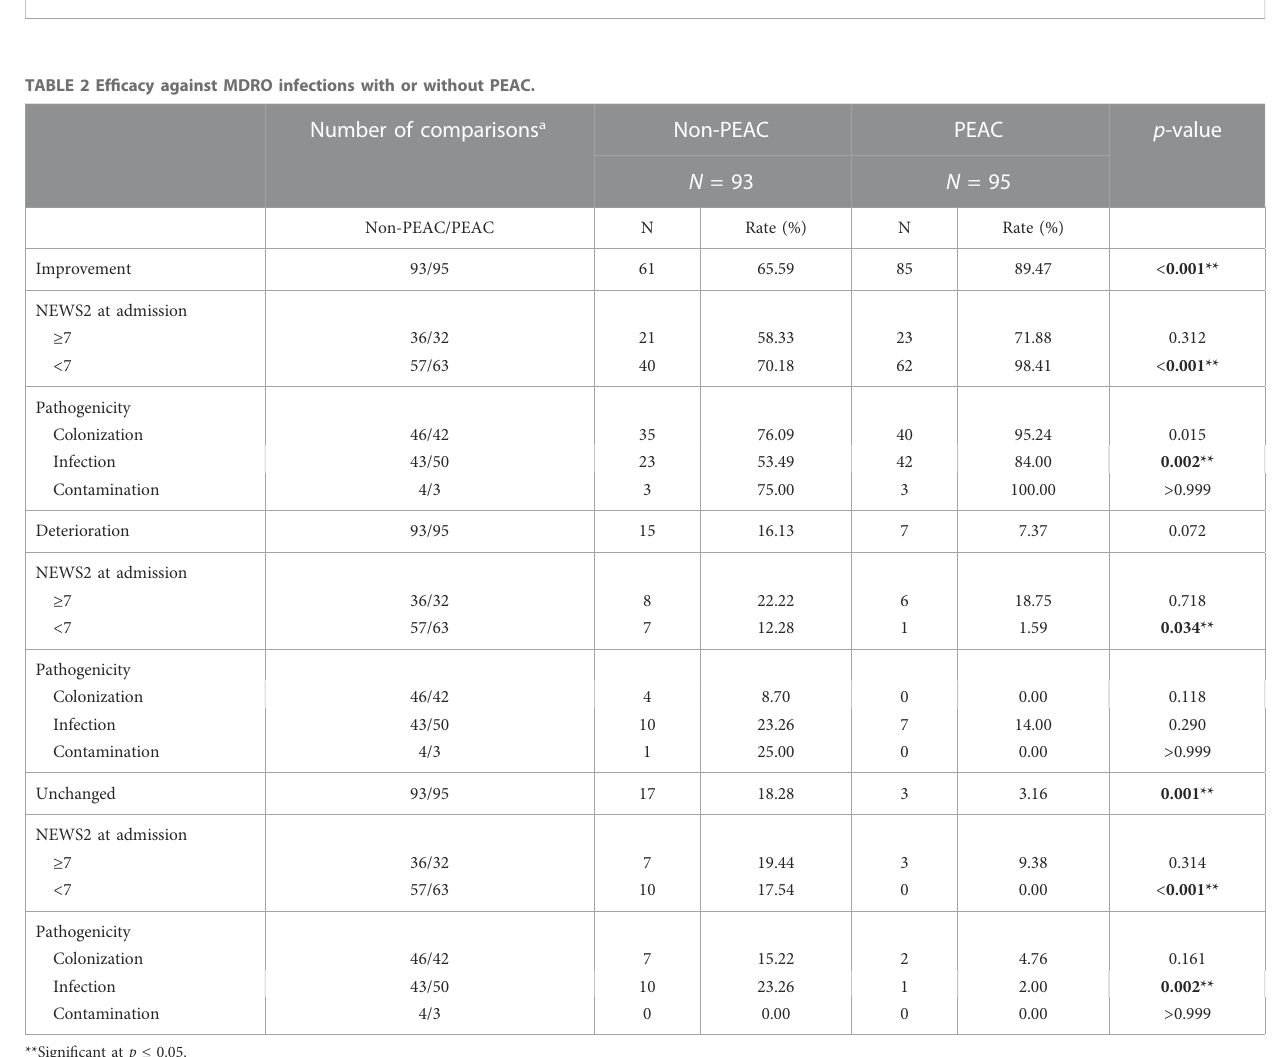
FIGURE 2 Univariate and multivariate analyses represent the relative risks (HR) of potential predictors for 30-day all-cause mortality and 95% con fi dence intervals (95% CI).